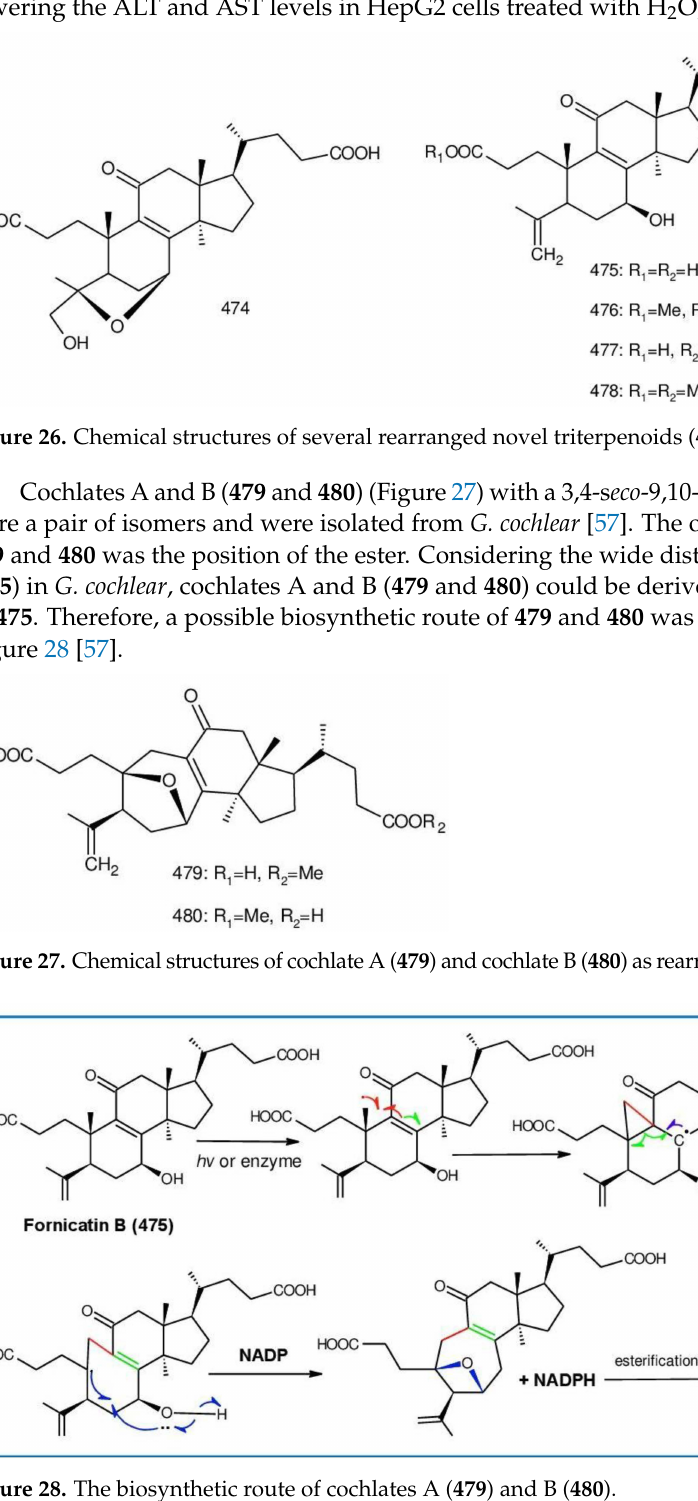
Figure 28. The biosynthetic route of cochlates A ( 479 ) and B ( 480